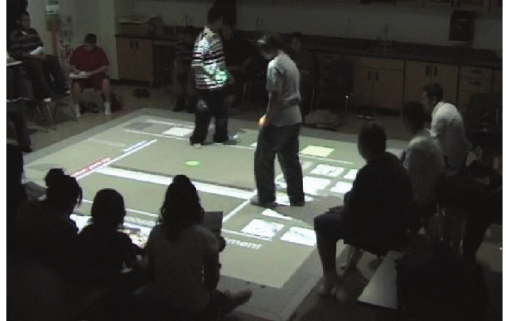
Figure 5: Students collaborating to compose a layer-cake structure in SMALLab .